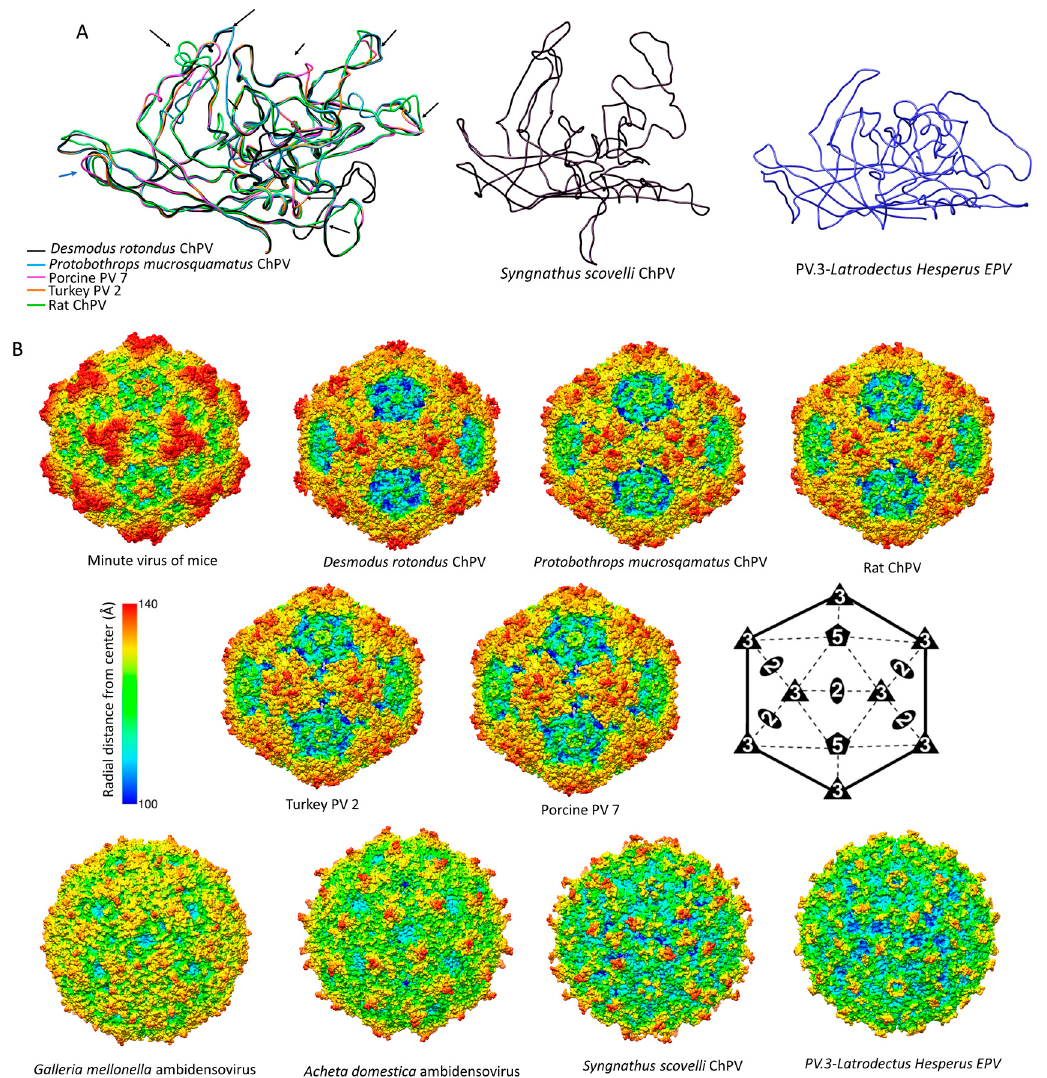
Figure 7. Comparison of chapparvoviruses (ChPV) capsid models of various host a ffi liations. ( A ) Homology models, shown as ribbon diagrams, representing the probable three di ff erent ChPV structural protein types. The first panel shows superposition of VP monomer homology models of amniote ChPV capsids, including reptilian, avian, rodent, chiropteran, and ungulate representatives. Black arrows show variable regions (VRs) previously identified by aligning the VP protein sequences. The next two panels show homology models of capsid monomers from a fish ChPV and an endogenous chapparvoviral element from an arthropod genome. ( B ) Capsid surface morphology of amniote ChPV homology models compared to that of the polymer structure of a prototypic parvovirus, the minute virus of mice (MVM) (PDB ID: 1Z14 at 3.25 Å resolution). Capsids are orientated by their